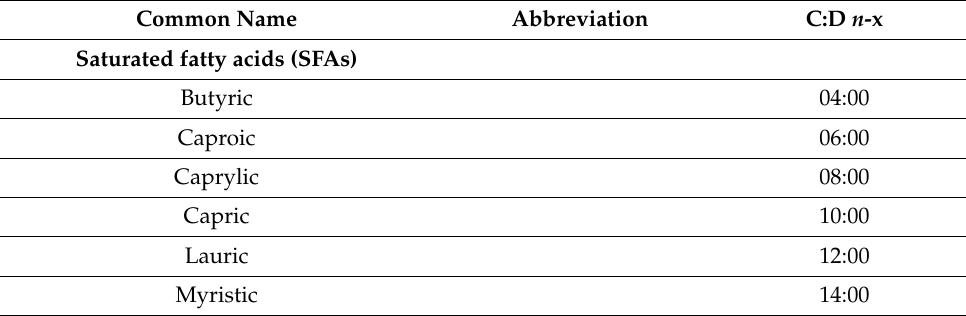
Figure 2. Naming of unsaturated fatty acids based on the position of the double bonds. According to one classification (IUPAC classification), this position refers to the distance from the carboxyl terminus, C1 (C-x). Alternatively, numbering refers to the distance of the double bond from the C atom of the methyl group, which is designated as n or ω . In n minus x ( ω minus x), a double bond of the fatty acid is located on the xth carbon–carbon bond counting from the terminal methyl carbon (designated as n or ω ) toward the carboxyl terminus. An 18-carbon FA is reported here as an example. The representation is idealized because, unlike saturated fatty acids, which have a straight-chain structure, PUFAs are typically bent. Table 2. Examples of FAs.